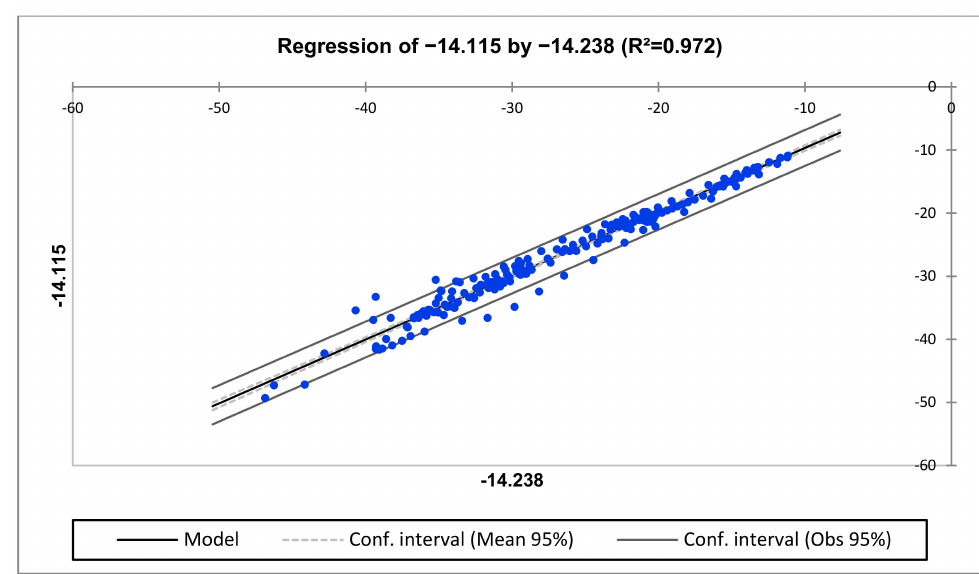
Figure 26. Regression for H3-H2 vs. H1-H3 (High-frequency